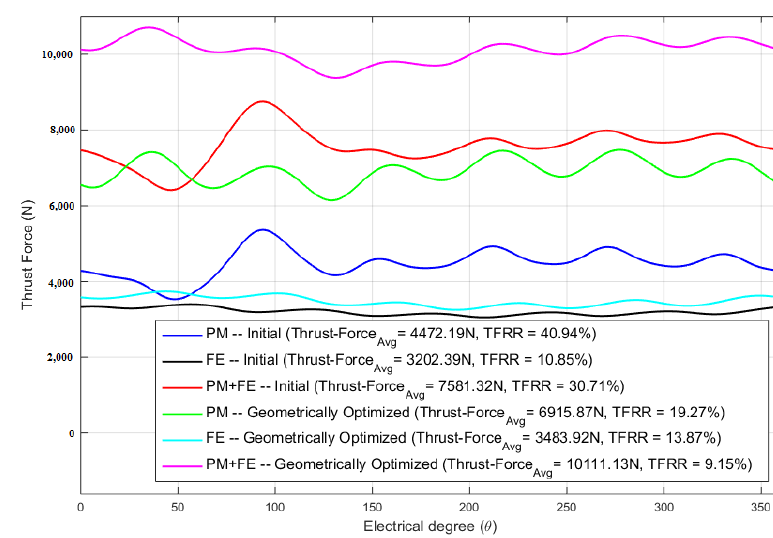
Figure 10. Thrust force comparison.